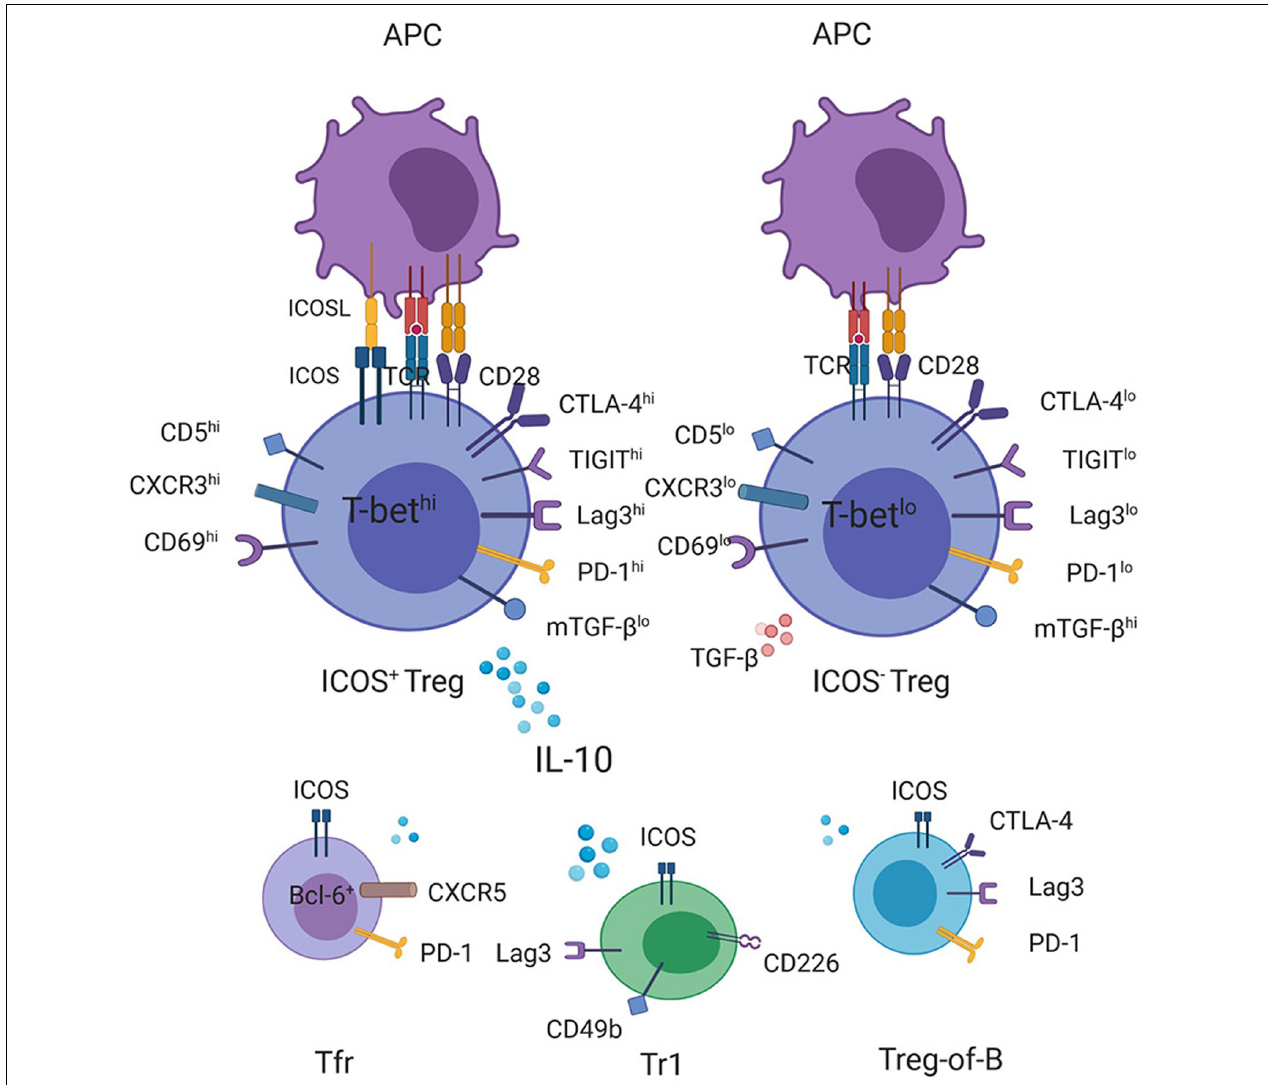
FIGURE 1 | Production of IL-10 by ICOS-expressing T cells with regulatory function. CD4 + ICOS + Tregs express high levels of IL-10 but smaller amounts of TGF- β compared with ICOS − Tregs. Transcriptome and FACS analyses have demonstrated a correlation between the increased ICOS expression on Tregs with the high expression levels of CD5, CD69, CXCR3, and T-bet as well as some checkpoint inhibitors, such as CTLA-4, TIGIT, Lag3, and PD-1, (15, 56, 57) some of which have been shown to promote the transcription of the IL-10 gene, contributing to high levels of IL-10 secretion together with ICOS. In addition, other